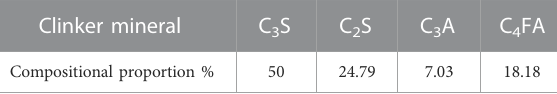
TABLE 2 Mineral composition of the cement clinker was used in this